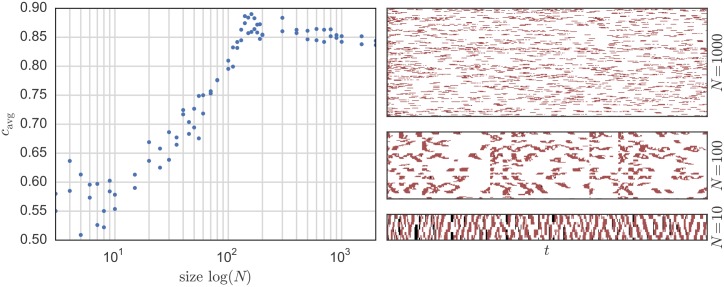
On the left: change in the average cooperation cavg depending on the system size N. On the right: examples of a typical system behavior as a function of time t where the points (pixels) represent the agent state Si[t] such that red means defection, white cooperation, and black doing nothing for N = 1000 (top), N = 100 (middle) and N = 10 (bottom). The system parameters are: λmin = 0.0005, RV = 2Ω, R0 = R/N = 200Ω, perr = 0.01 and V = 1 V. The communication network is configured as a ring.